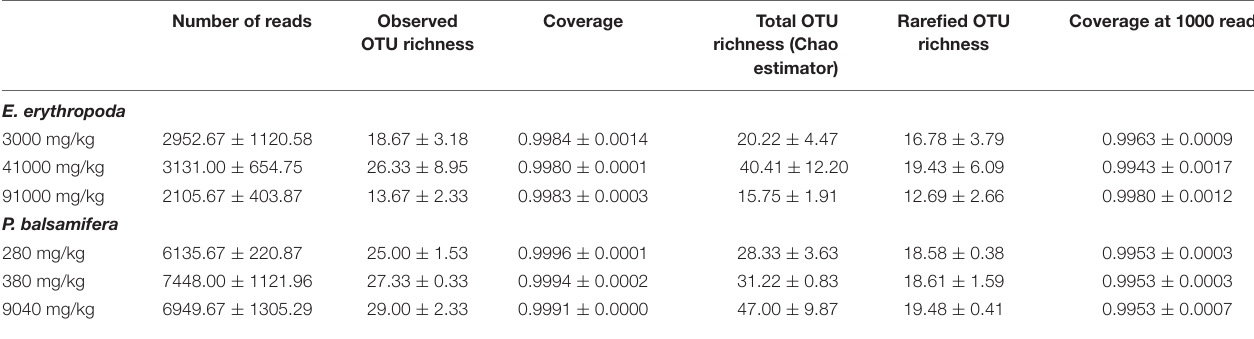
TABLE 3 | Mean and standard error of the number of reads, richness and coverage of fungal OTUs recovered by 454 pyrosequencing. Number of